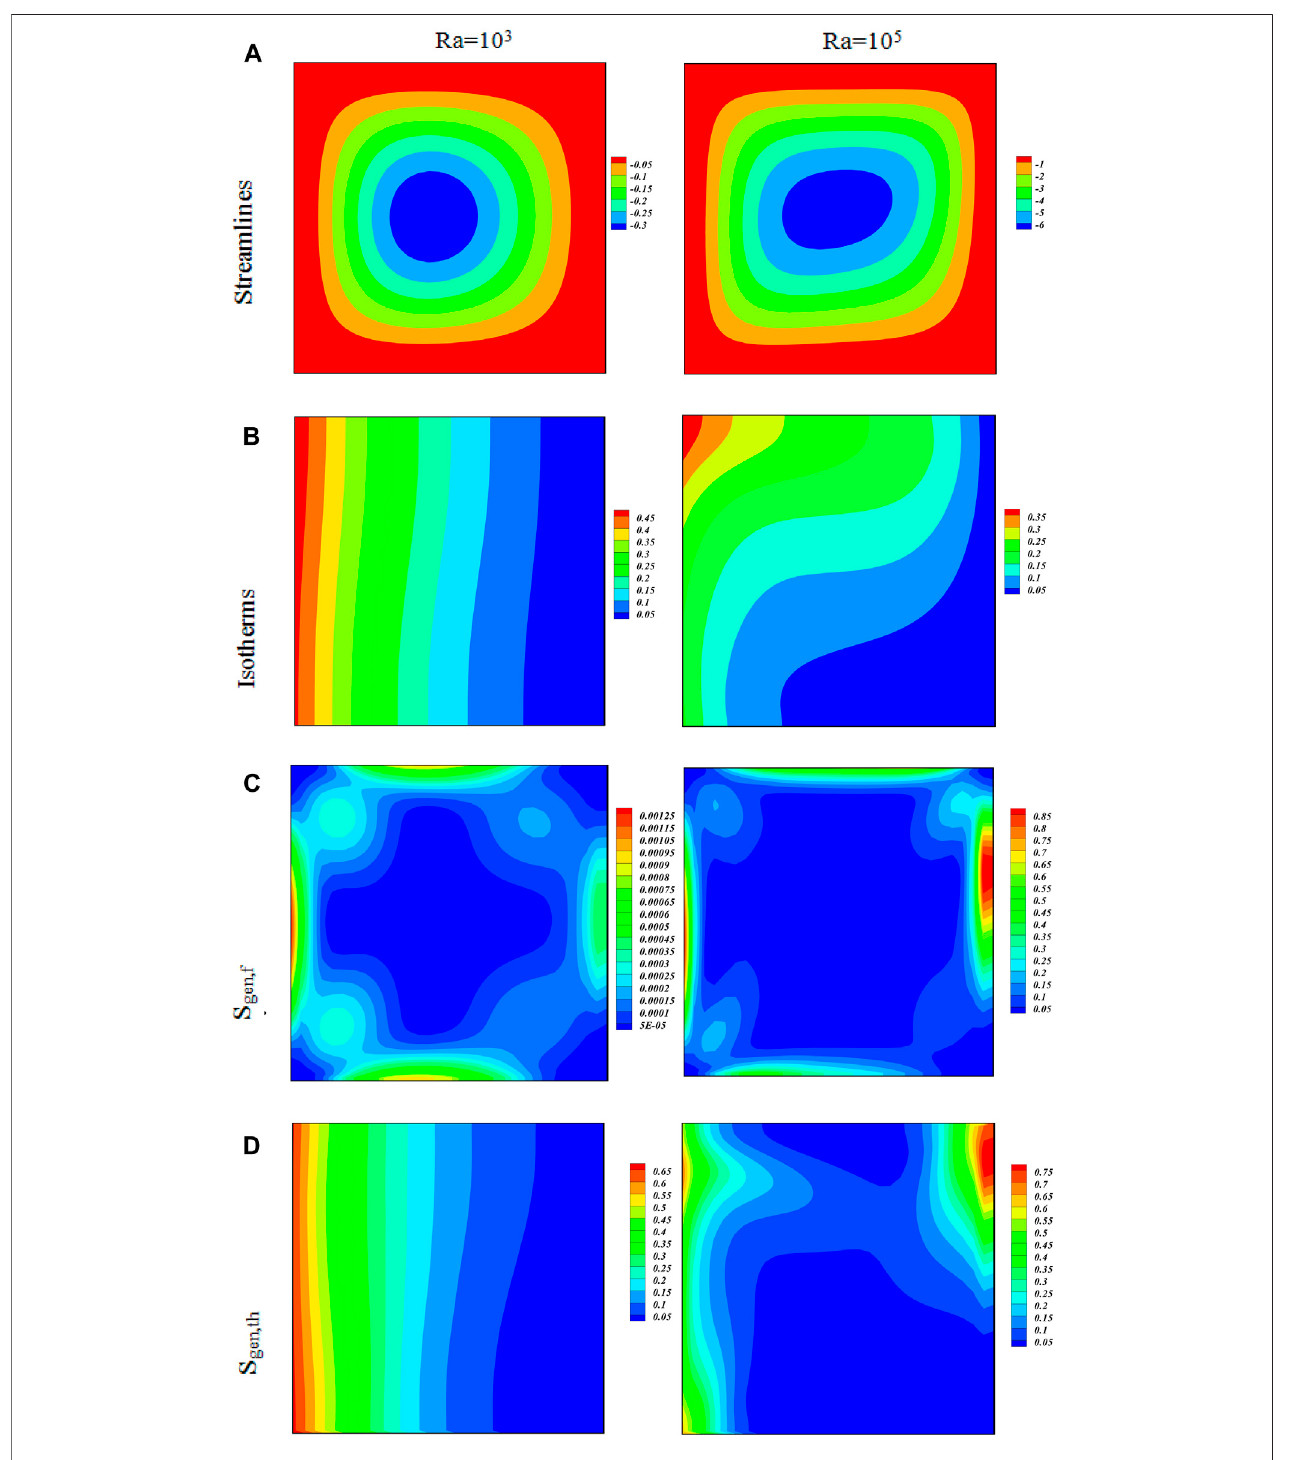
FIGURE 3 | Contour of streamlines, isotherms, irreversibility, and the Bejan Number changes at ϕ (cid:1) 0 . 04 , Ha (cid:1) 1 , Da (cid:1) 100 .